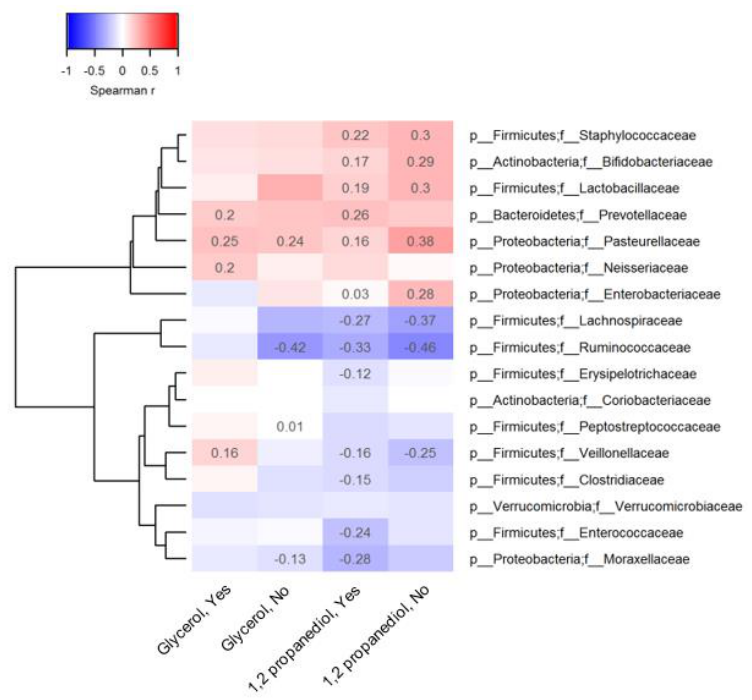
Figure 1. Association between observed 1,2 propanediol, glycerol and representative taxa at the family level.